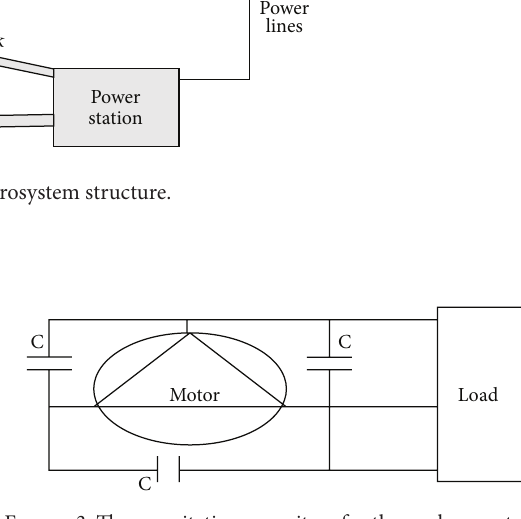
Figure 3: Three excitation capacitors for three-phase output. Table 1: Induction Machine